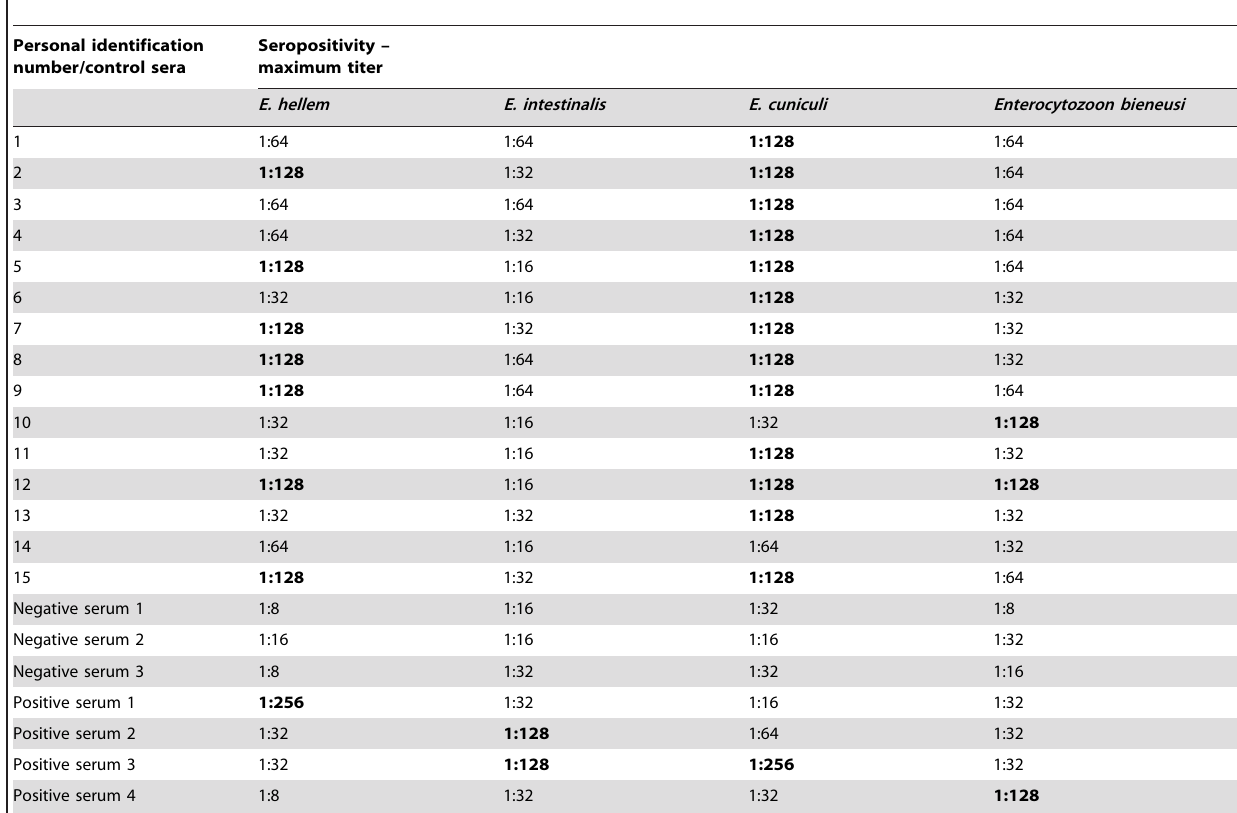
Personal identification number/control sera